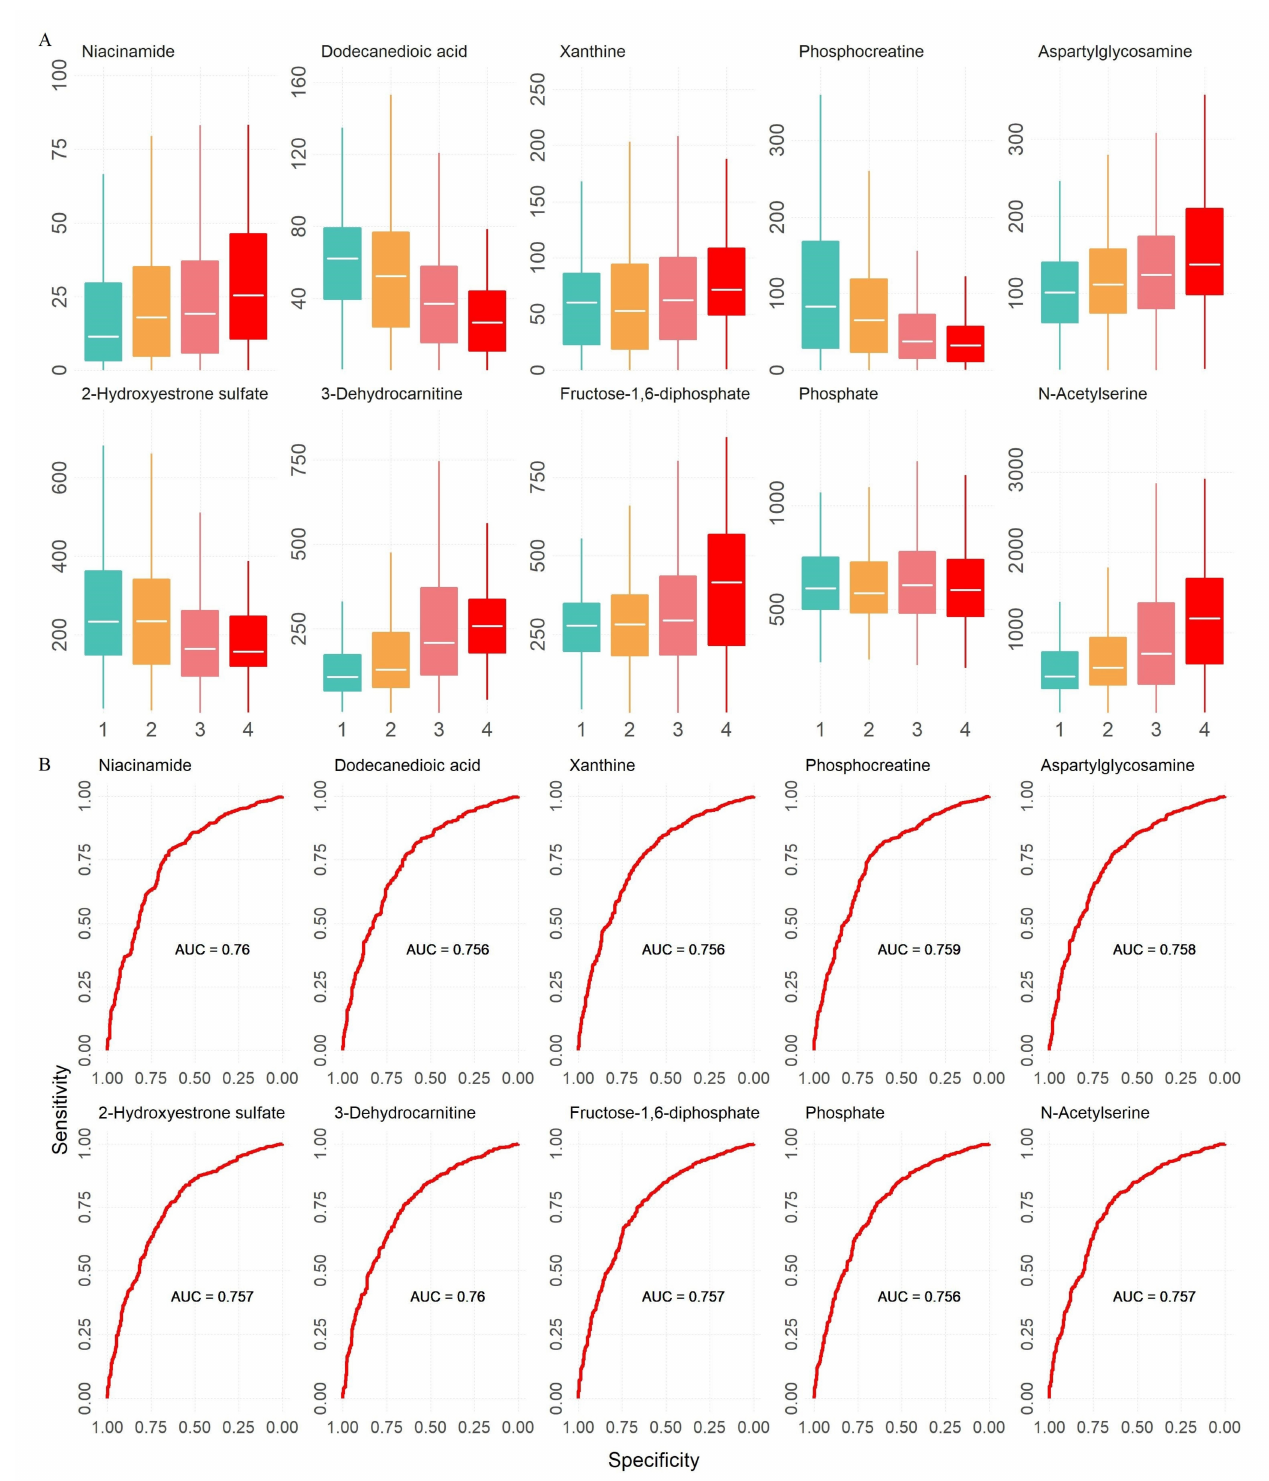
Figure 1. The final ten metabolites that were associated with blood pressure. ( A ). The box plots of the final ten metabolites’ abundances by blood pressure stages (1–4): 1 indicates normal blood pressure, 2 indicates prehypertension, 3 indicates hypertension, 4 indicates crisis. ( B ). The ROC curves of the ten metabolites when treating blood pressure as binary (normal vs. high). Together, these ten metabolites explained 13.42% variation in blood pressure (adjusted R 2 = 0.1342). By combining clinical characteristics, the total explainable variance of